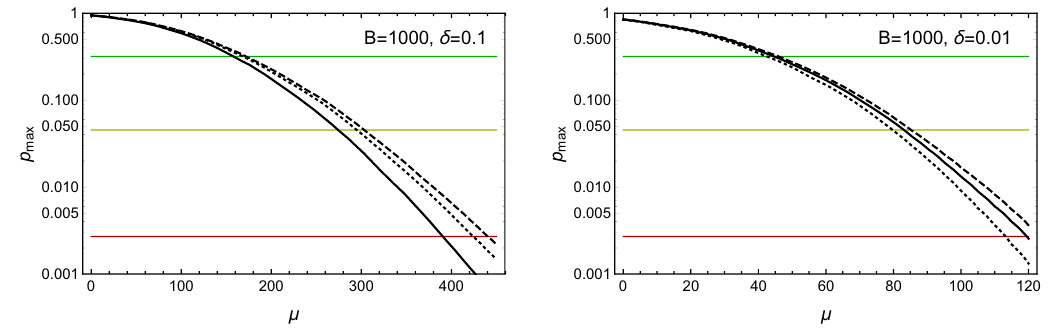
Figure 7 . The expected p -value for B = 1000, (cid:14) = 0 : 1 (left) and (cid:14) = 0 : 01 (right). Results are obtained for di(cid:11)erent values of B and (cid:14) , starting from B = 10 and (cid:14) = 0 : 1 and (cid:14) = 0 : 01, shown in (cid:12)gure 5. The level of agreement is comparable to the one